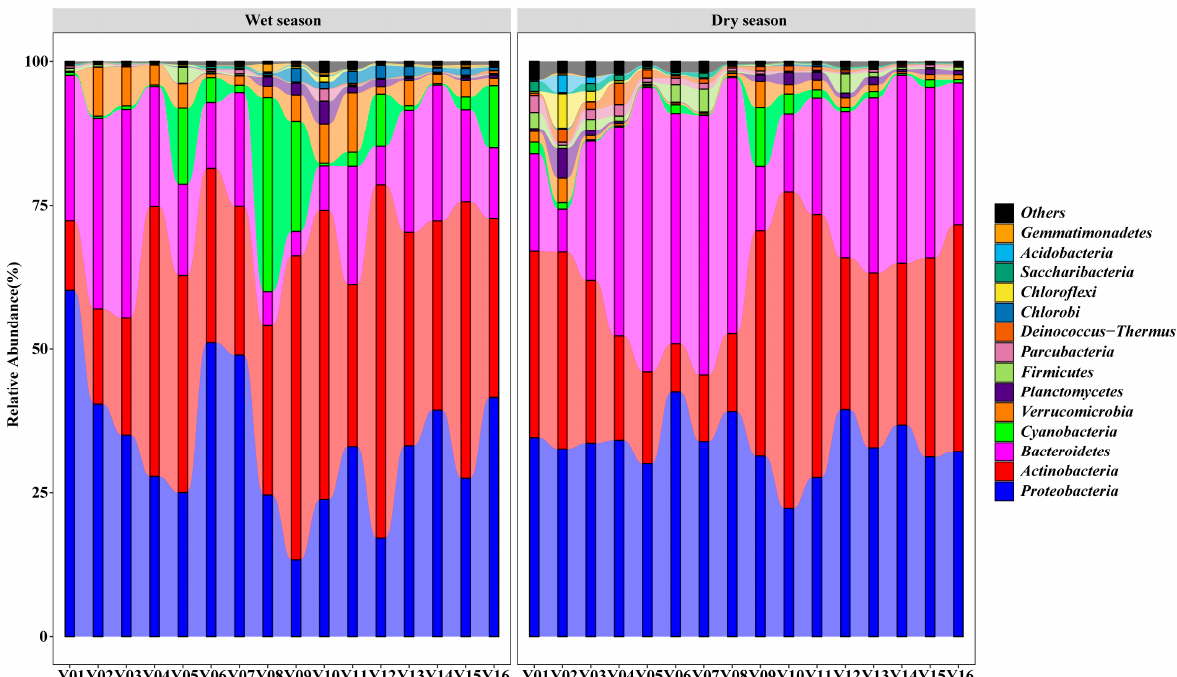
Figure 2. Phylum-level taxonomic composition of the bacterial community under different soil and water conservation measures. Note: the parts with an average abundance of less than 1% were merged and indicated by “others” in the figure.